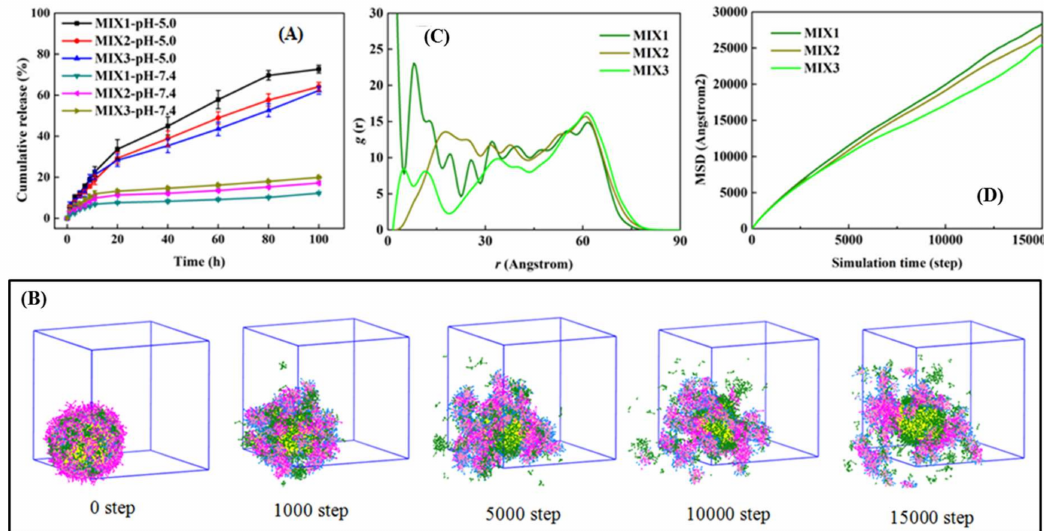
Figure 7. In vitro drug release profiles ( A ) at pH 7.4 and pH 5.0; ( B ) DOX release process of MIX1 (LC, 31.23%) in acidic aqueous solution; ( C ) radial distribution functions (RDF) curves between DOX and the micellar center; ( D ) mean square displacements (MSD) curves of the DOX-loaded mixed micelles MIX1 (LC, 31.23%), MIX2 (LC, 26.53%), and MIX3 (LC,